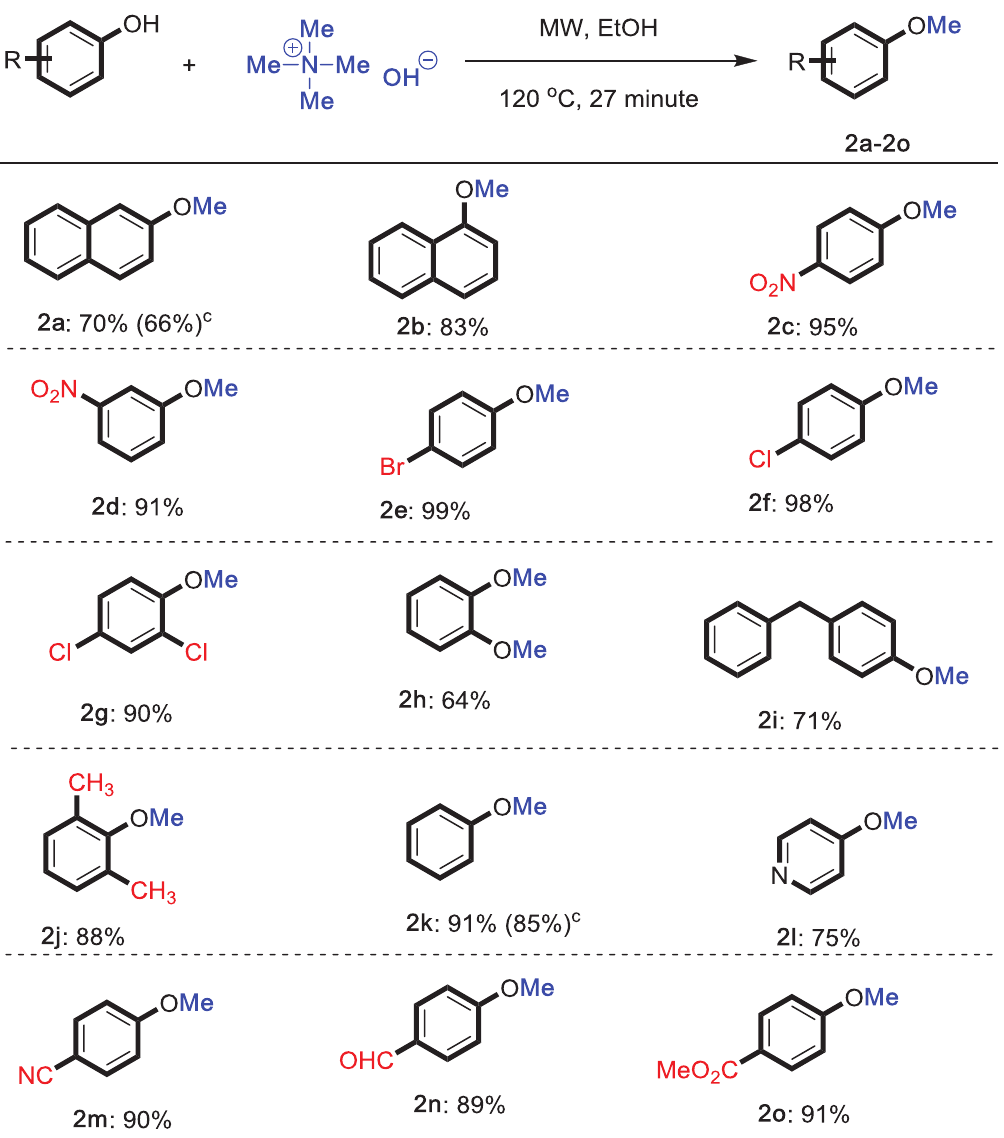
Figure 2: Products of O-methylation of different phenolic compounds using TMAH reagent under MW irradiation. a) Reaction conditions: phenolic compound (1 mmol), TMAH (1 mmol), solvent (6 mL). b) All yields refer to GC yield. c) Isolated